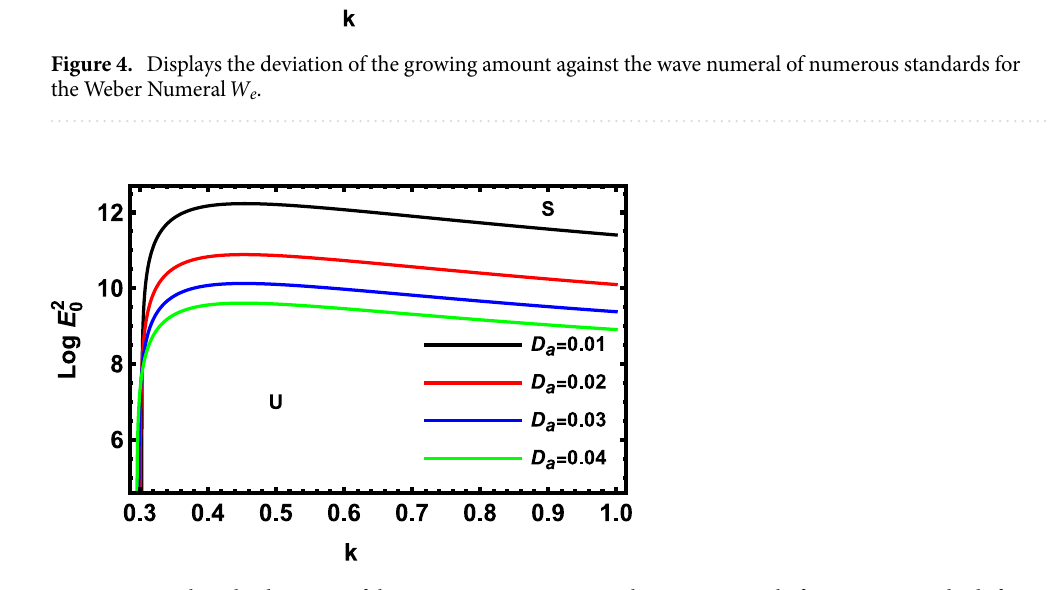
Figure 5. Displays the deviation of the growing amount against the wave numeral of numerous standards for the Darcy Numeral D a